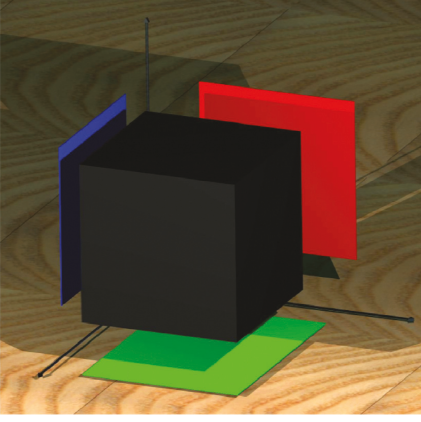
Figure 4: Decomposition D